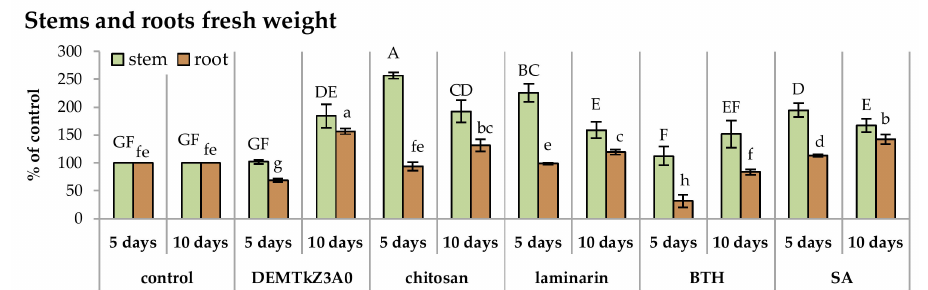
Figure 14. The fresh weight of wheat seedlings stem and root expressed as % of non-inoculated control after 5 and 10 days inoculation with Trichoderma DEMTkZ3A0 strain and potential inducers (commercial elicitors) of plant resistance: Chitosan, laminarin, BTH, and SA.